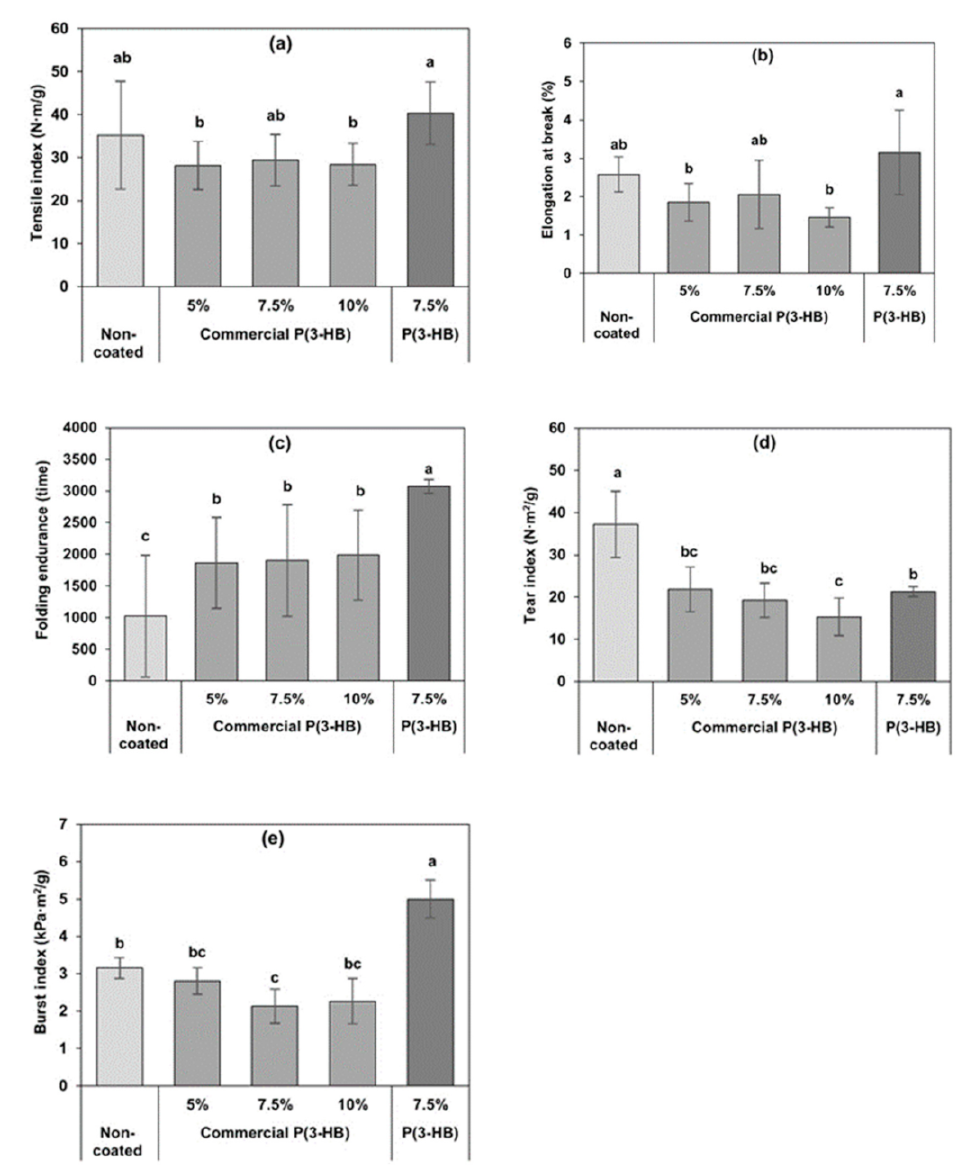
Figure 4. Mechanical properties of the non-coated PLFP, the commercial P(3-HB) coated PLFPs at 5%, 7.5% and 10% ( w / v ) and the biosynthesized P(3-HB) coated PLFP at 7.5% ( w / v ) including ( a ) tensile index, ( b ) elongation, ( c ) folding endurance, ( d ) tear index and ( e ) burst index. Different letters above graph bars re represent the different between the averages of each parameter at significance level of p ≤